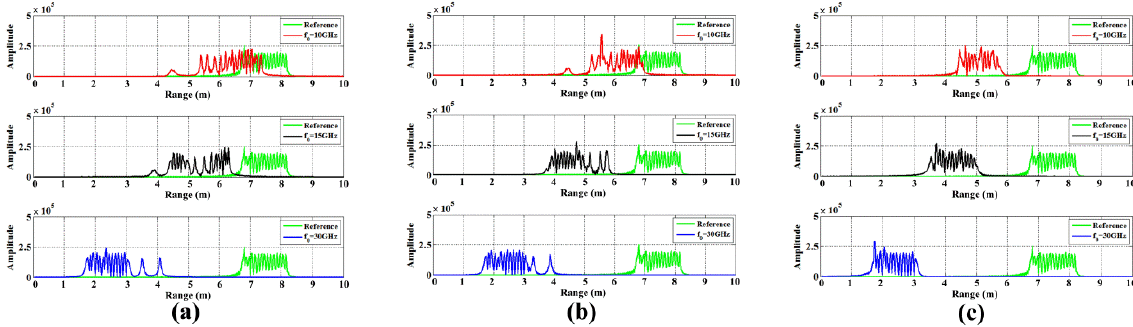
Figure 17. One-dimensional range profiles of the hypersonic target in scenes 1, 2, and 3. ( a ) Alti- tude is 30 km. ( b ) Altitude is 40 km. ( c ) Altitude is 50 km. When flight speeds are increased to Mach 20 and Mach 25, similar one-dimensional range profiles are observed. The stagnation point is located on the far left, and the other scattering points have a small offset. As shown in Figure 18, one-dimensional range pro- files are stretched and deformed.